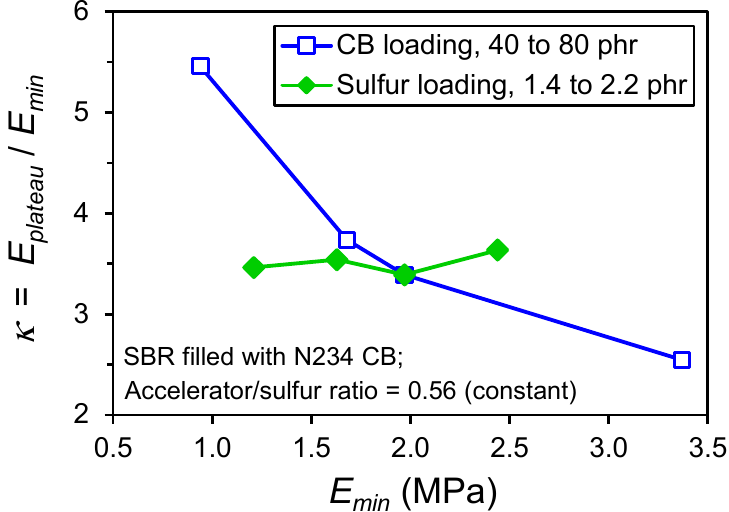
Figure 8. Regions of filler reinforcement illustrated using tensile stress–strain curve and its derivative (slope; modulus ( E )) for N234 CB-filled SBR ( φ = 0.22) with 1.8 phr sulfur. Stress– strain data from Warasitthinon and Robertson [11]. Unitless strain (not %) used when deter- mining E . The dashed vertical lines separate the five regions.